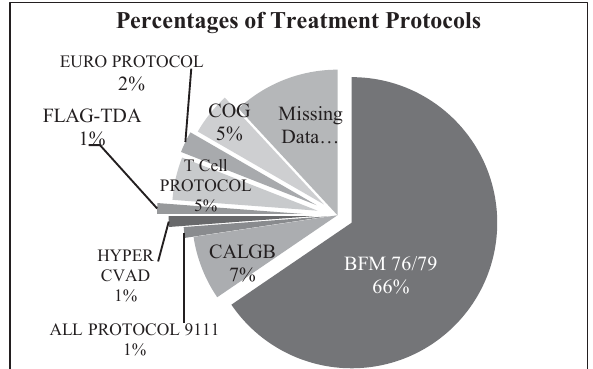
Fig-2: %age of patients treated with protocols